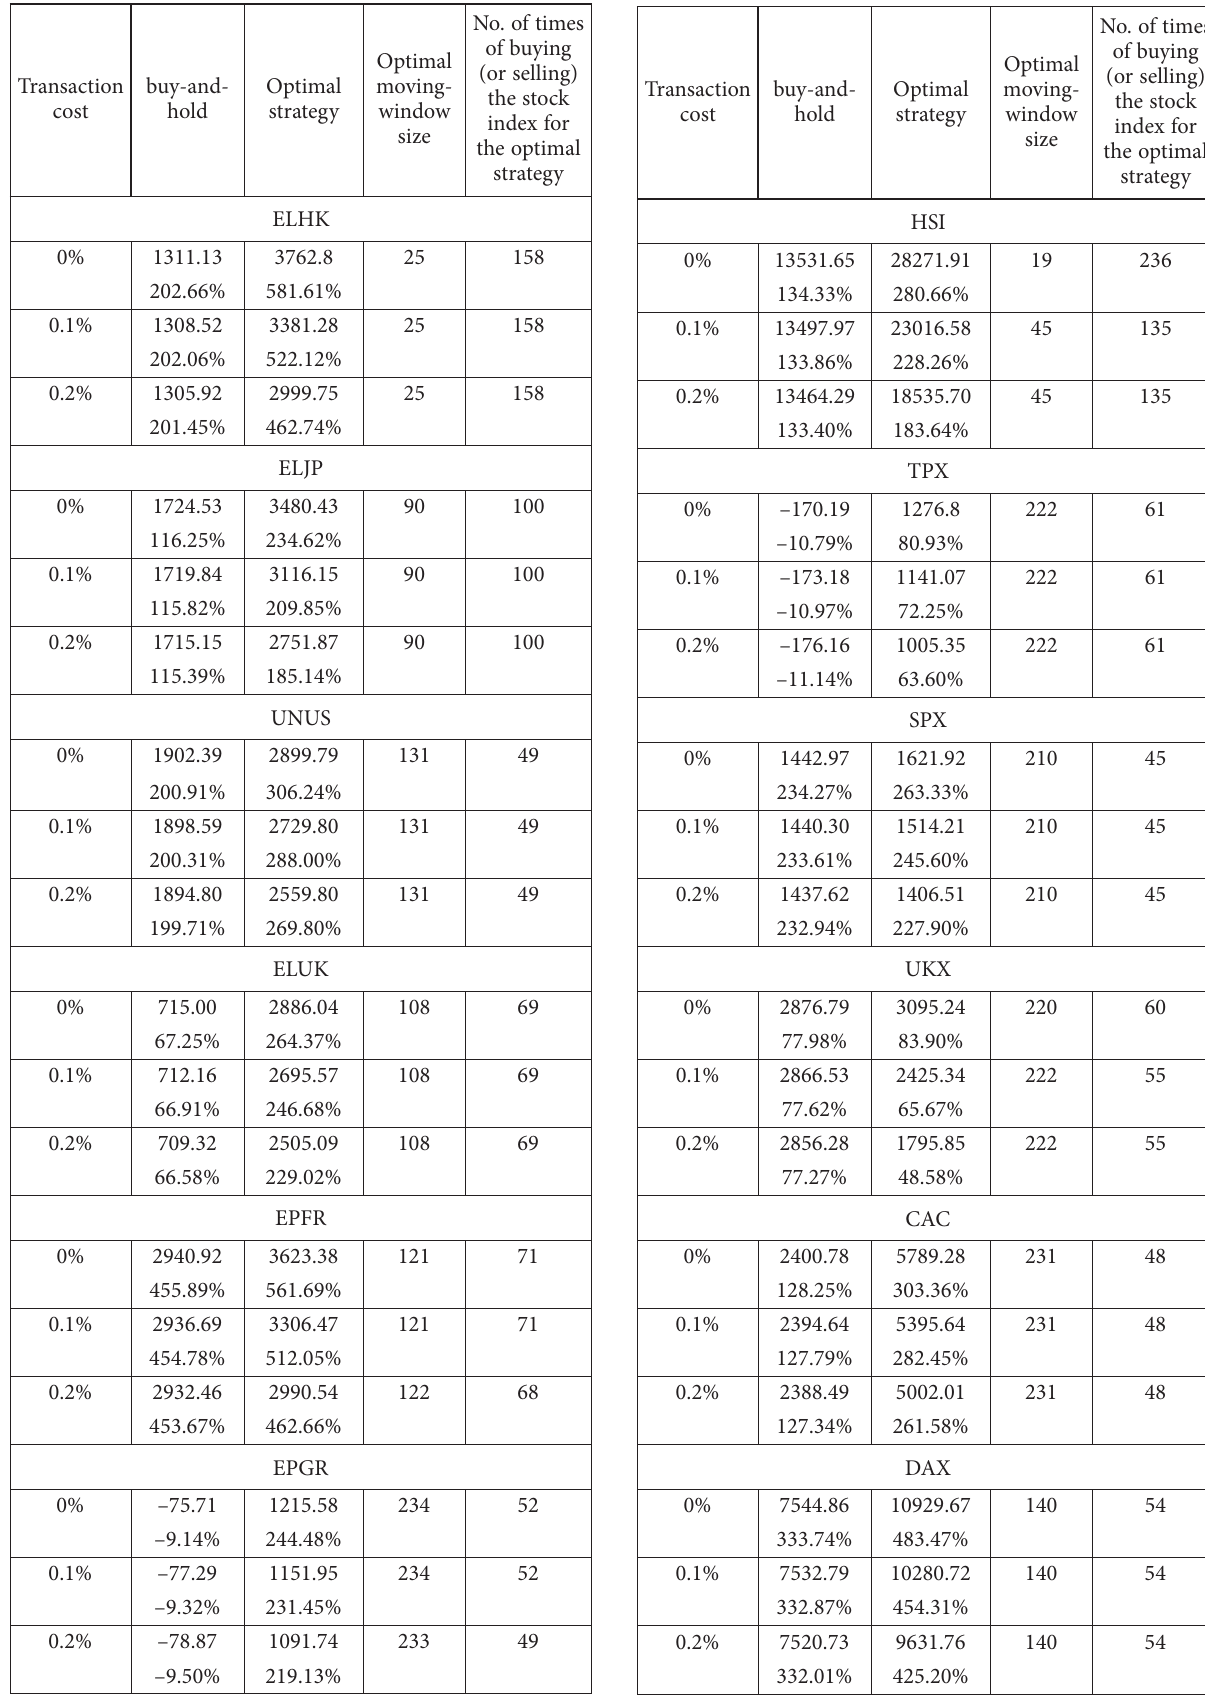
Table 4. The optimal moving-window sizes